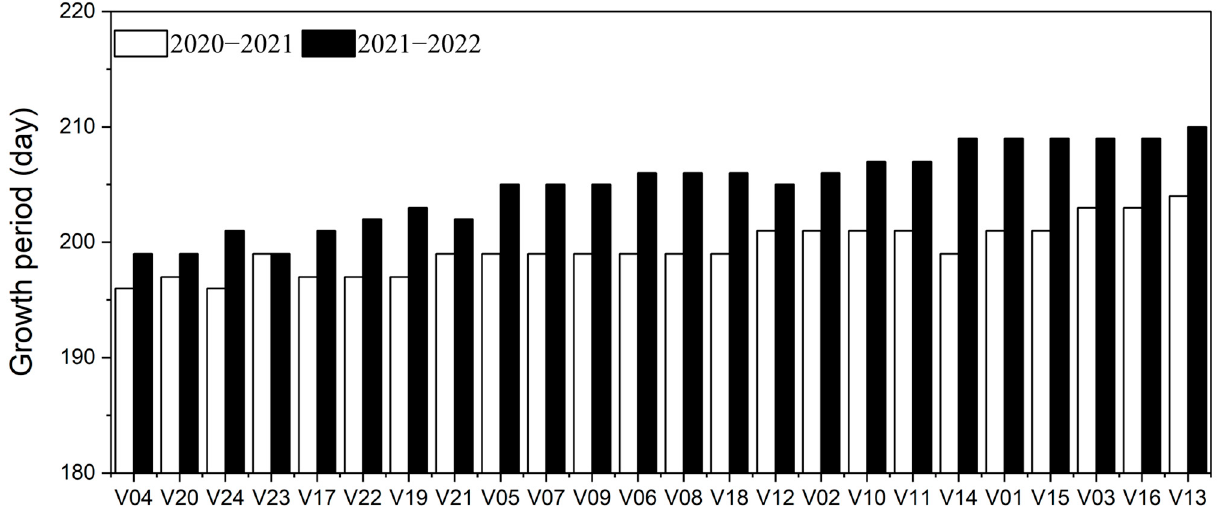
Figure 3. Growth periods of the tested varieties during two cropping seasons. The varieties on the x -axis were ordered according to the average growth period across two growing seasons.